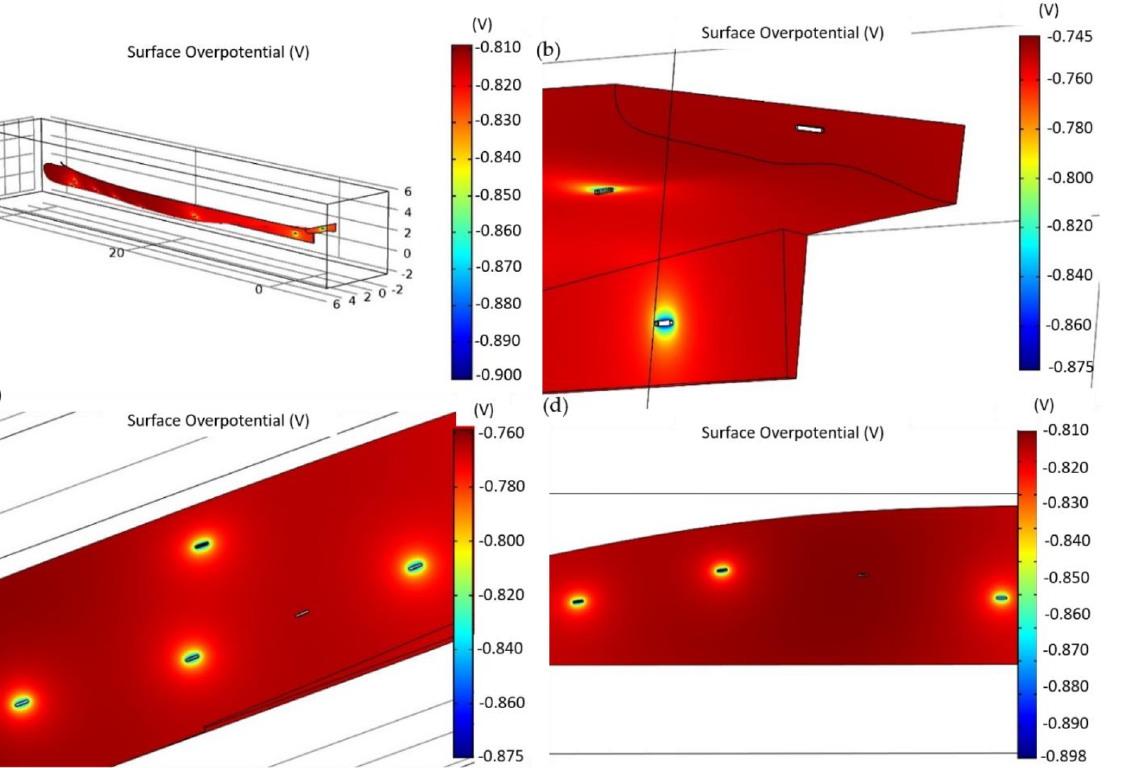
Figure 6. ( a ) Global view of the results of the numerical analysis with 2.7 kg anodes. ( b – d ) show the effect of deactivation of one anode in ( b ) transom, ( c ) stern body, ( d ) central